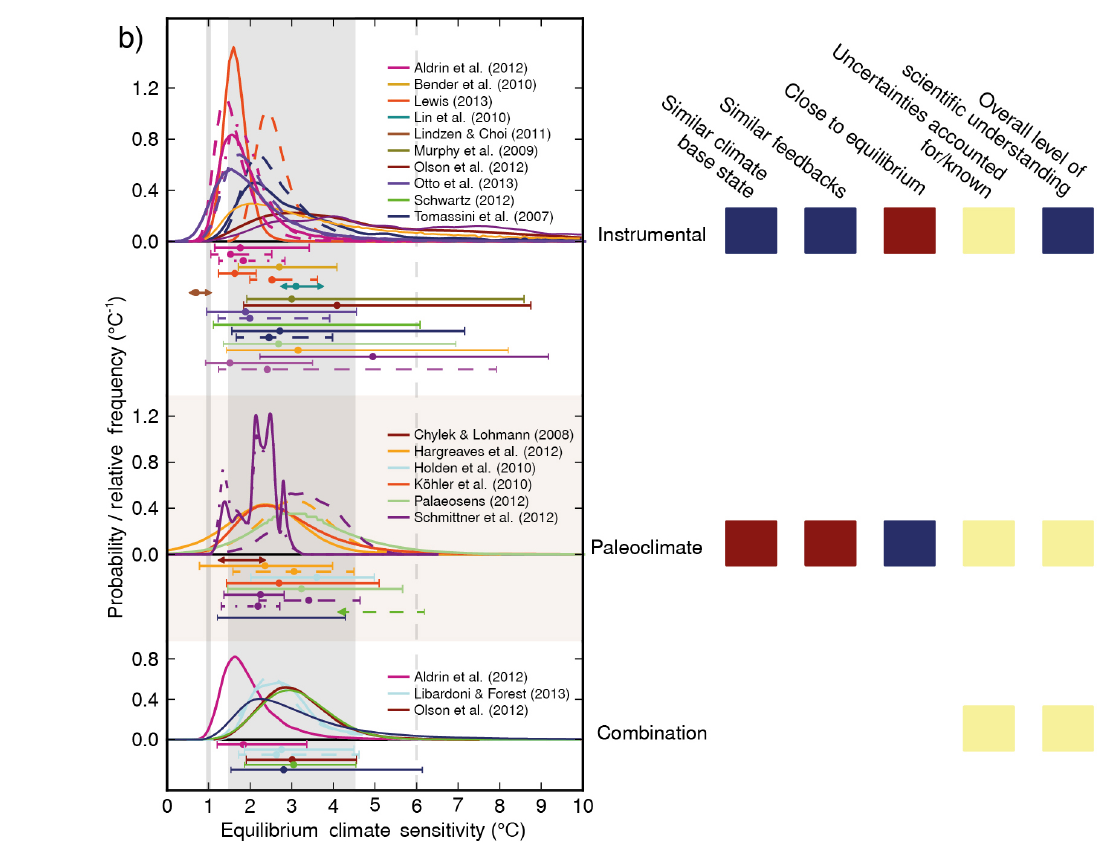
Figure 13. Probability density distributions of ECS according to IPCC AR5 WG-I (Bindoff et al., 2013, Fig. 10.20).